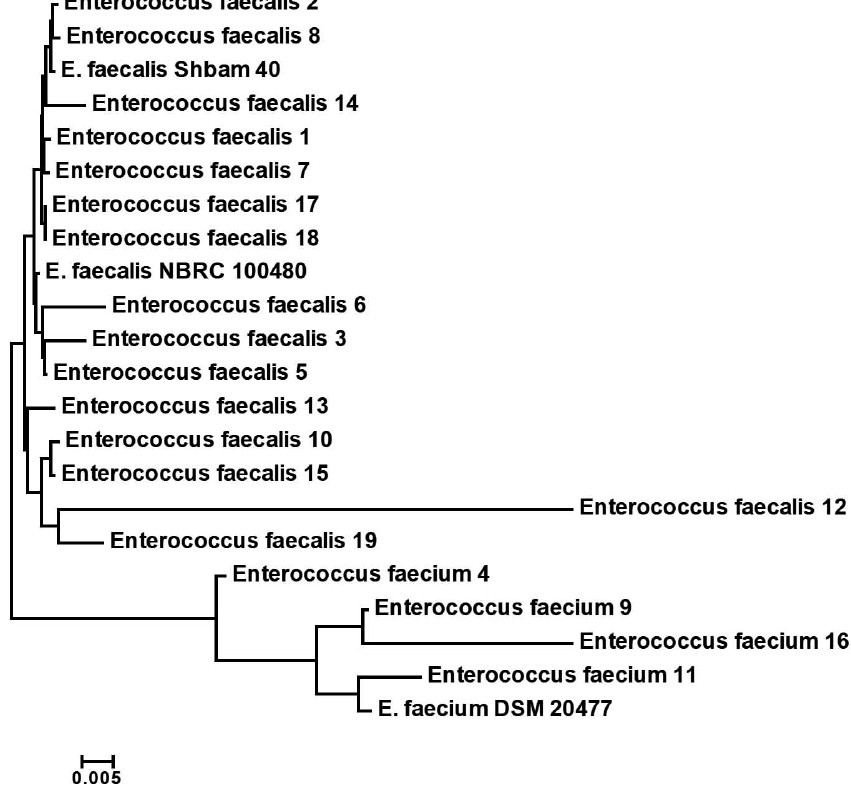
Fig. 1. Phylogenetic relationship of the multi-Drug resistance Enterococcus isolates and related genera based on full size 16S rDNA sequences. The tree was constructed using neighbor joining algorithm with Kimura 2 parameter distances in MEGA 7.1 software. The bar indicates the Juke-Cantor evolutionary